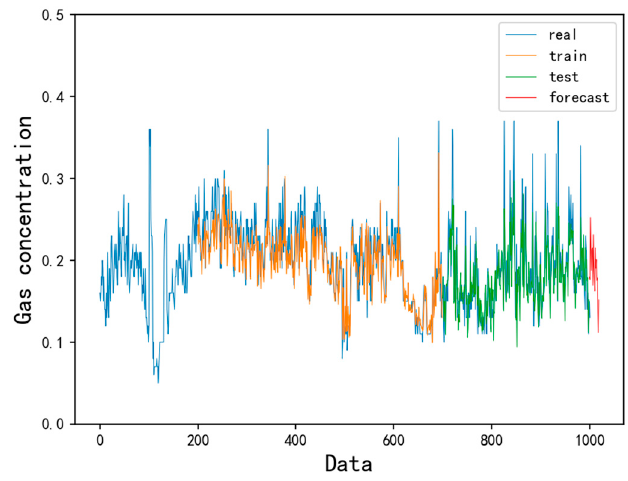
Figure 18. Verifying the prediction results.